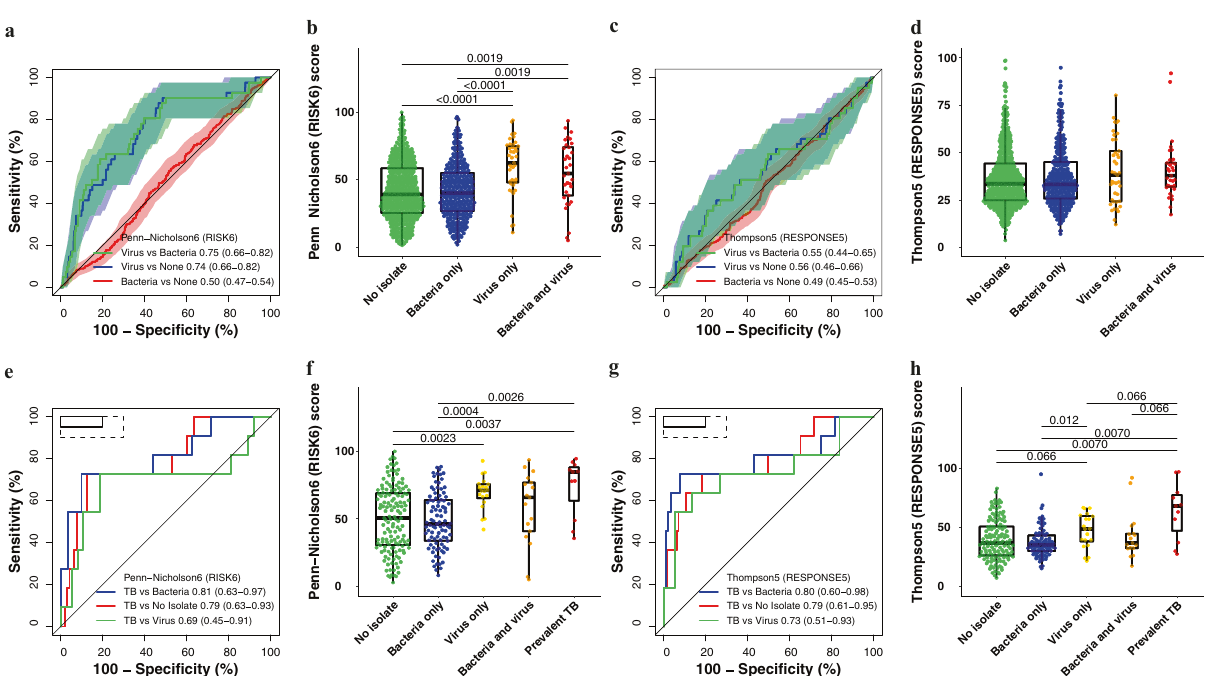
Fig. 6 Parsimonious signature performance for differentiating participants with viral or bacterial upper respiratory tract pathobionts, those without any pathobionts, and participants with prevalent TB. Representative receiver operating characteristic (ROC) curves and box-and-whisker plots for the ( a , b ) Penn-Nicholson6 (RISK6) and ( c , d ) Thompson5 (RESPONSE5) signatures in all participants without prevalent TB in the Respiratory Pathobionts sub- study (11 participants with secondary endpoint prevalent TB excluded). ROC curves and box-and-whisker plots for the other signatures are in the Supplementary Information (Fig. S12). The box-and-whisker plots depict signature score distributions in participants with no upper respiratory pathobionts ( n = 563), bacterial upper respiratory pathobionts only ( n = 352), viral upper respiratory pathobionts only ( n = 41), both viral and bacterial upper respiratory pathobionts (n = 33). The ROC curves depict performance (area under the curve, AUC, with 95% CI) of the parsimonious signatures in differentiating between participants with viral upper respiratory pathobionts and participants with bacterial upper respiratory pathobionts, between participants with viral pathobionts and those with no pathobionts, or between participants with bacterial pathobionts and those with no pathobionts. The shaded areas represent the 95% CIs. Representative ROC curves and box-and-whisker plots for the ( e , f ) Penn-Nicholson6 (RISK6) and ( g , h ) Thompson5 (RESPONSE5) signatures in all participants randomised in the CORTIS-01 study and co-enroled in the Respiratory Pathobionts sub-study. Participants who were not randomised in the CORTIS-01 study, and thus not investigated for TB, are not included. ROC curves and box-and-whisker plots for the other signatures are in the Supplementary Information (Fig. S13). The ROC curves depict performance of the parsimonious signatures in differentiating between participants with prevalent TB ( n = 11) and participants with viral upper respiratory pathobionts ( n = 37), participants with bacterial upper respiratory pathobionts only ( n = 95), and participants with no pathobionts ( n = 143). Participants with both viral and bacterial pathobionts ( n = 17) were included in the group with viral pathobionts only ( n = 20) as the presence of bacterial pathobionts did not appear to affect signature scores. The solid box depicts the optimal criteria (95% sensitivity and 80% speci fi city) and the dashed box depicts the minimal criteria (90% sensitivity and 70% speci fi city) set out in the WHO Target Product Pro fi le for a triage test 20 . The box-and-whisker plots depict signature score distribution in participants with no upper respiratory pathobionts, bacterial upper respiratory pathobionts only, viral upper respiratory pathobionts only, both viral and bacterial upper respiratory pathobionts, and Mycobacterium tuberculosis detected on GeneXpert MTB/RIF or MGIT culture (microbiologically con fi rmed secondary endpoint prevalent TB; i.e. TB con fi rmed on at least one sputum sample). p-values for comparison of median signature scores between groups in box-and-whisker plots were calculated with the Mann – Whitney U test and corrected for multiple comparisons by use of the Benjamini – Hochberg Procedure 39 . Only p-values below 0.1 are shown. Each dot represents a participant. Boxes depict the IQR, the midline represents the median, and the whiskers indicate the IQR ± (1.5 ×